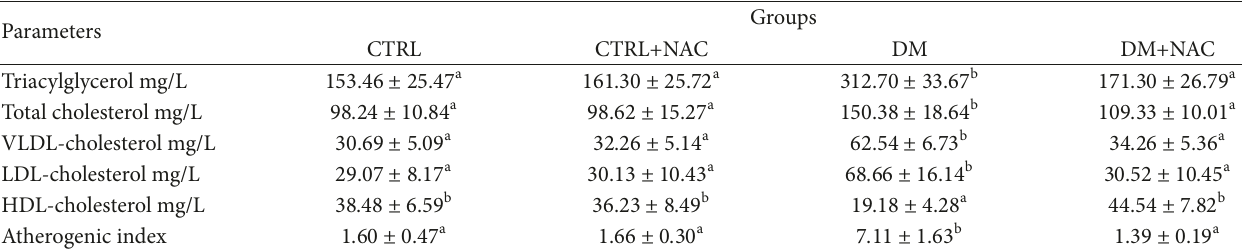
Table 3: Lipid profile in diabetic rats that have been treated and not treated with